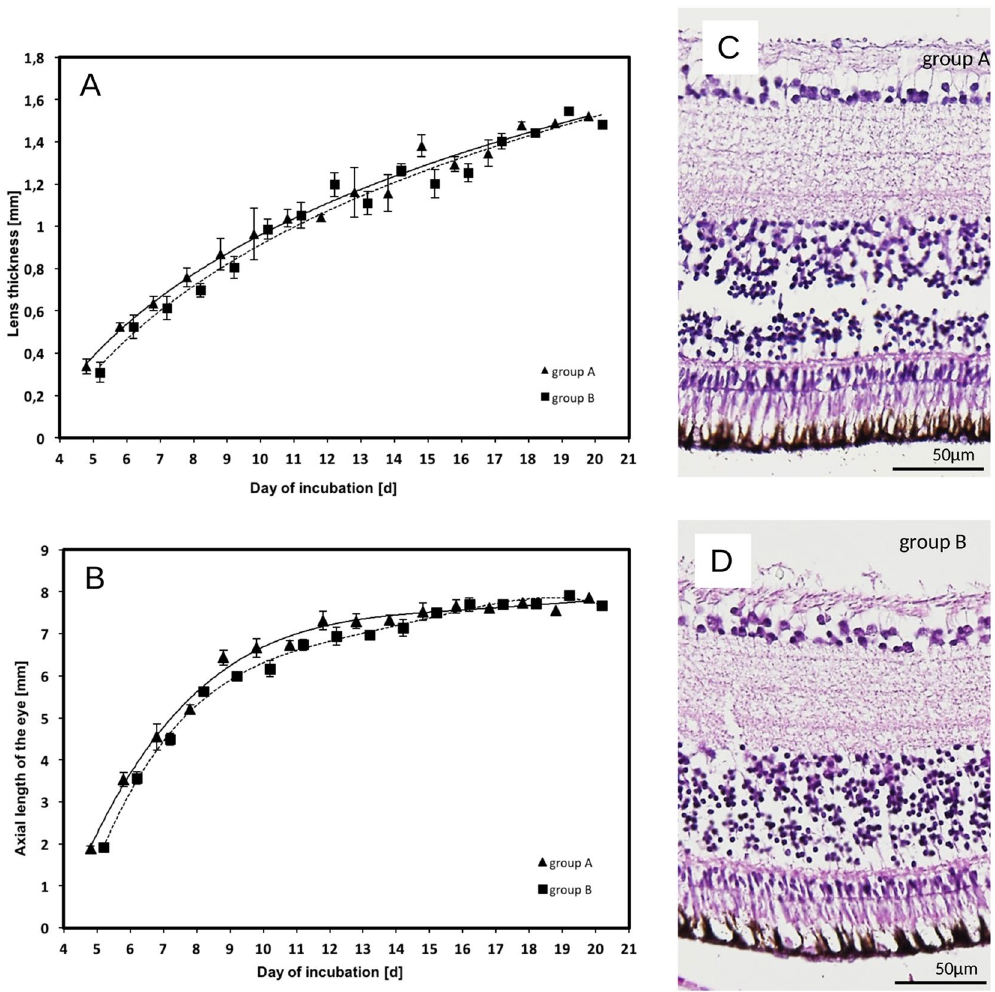
Figure 5. ( A and B ) Lens thickness and axial length of the eyeball in Groups A and B by day of incubation starting from E5 (note: data points ▲ and ■ are shifted slightly for each day to prevent marker overlap). ( C and D ) Examples of HE staining of the E20 retina for Group A and B for retinal ganglion cell counting.